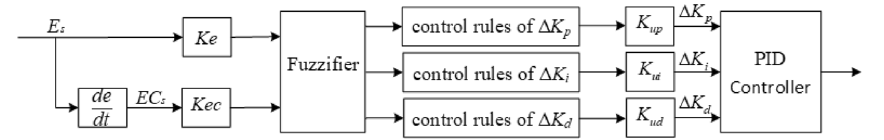
Figure 7. The block diagram of the fuzzy controller.